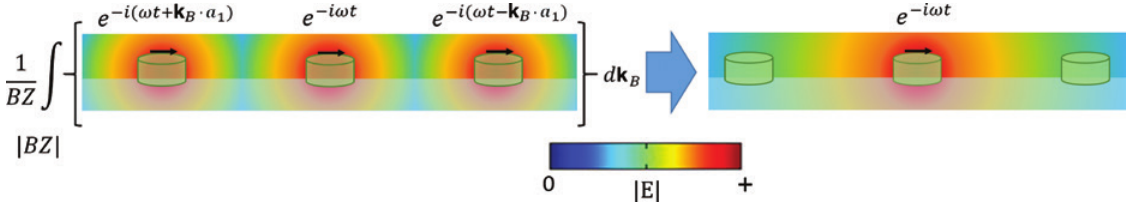
Figure 8: Schematic illustrating the array scanning method. A single dipole on the periodic metasurface is modeled as a sum of lattices of phased dipoles. Each dipole is represented as a black arrow and a corresponding